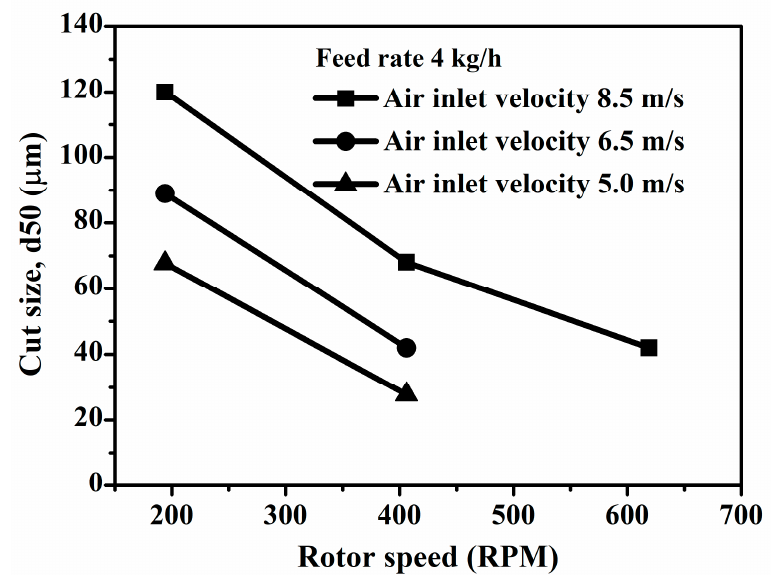
Figure 8. Plot of cut size against rotor speed for the experiments performed at air inlet velocities of 5, 6.5, and 8.5 m / s and a feed rate of 4 kg / h (of note is that for the results at rotor speed 619 RPM and air inlet velocities 5 and 6.5 m / s, the Tromp curves of classification used for evaluating cut size could not be constructed—see explanation in the text).